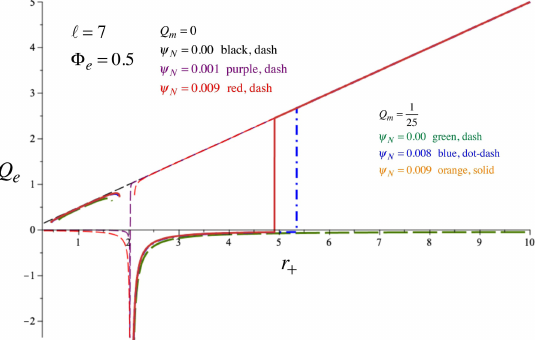
Figure 14 . Electric charge vs. Horizon size at fixed electric potential. This plot of Q e vs. r + at ψ ( I ) = 0 exhibits a single discontinuity for vanishing magnetic charge Q m = 0 , that widens as ψ ( I ) N increases, with a positively charged black hole becoming negatively charged at sufficiently small r + . If Q m 6 = 0 a second discontinuity appears if ψ ( I ) 6 = 0 , and there is an intermediate range of r + N where Q e < 0 . This region narrows as ψ ( I ) increases. Here ‘ = 7 and Φ e = 0 . 5 N